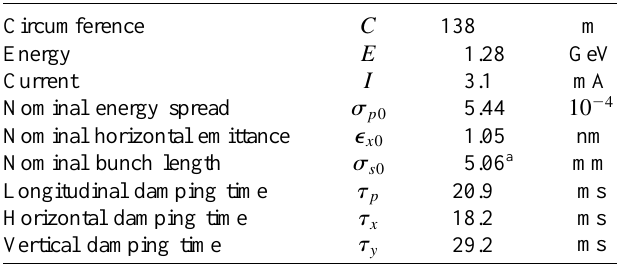
TABLE I. Typical ATF parameters in single bunch